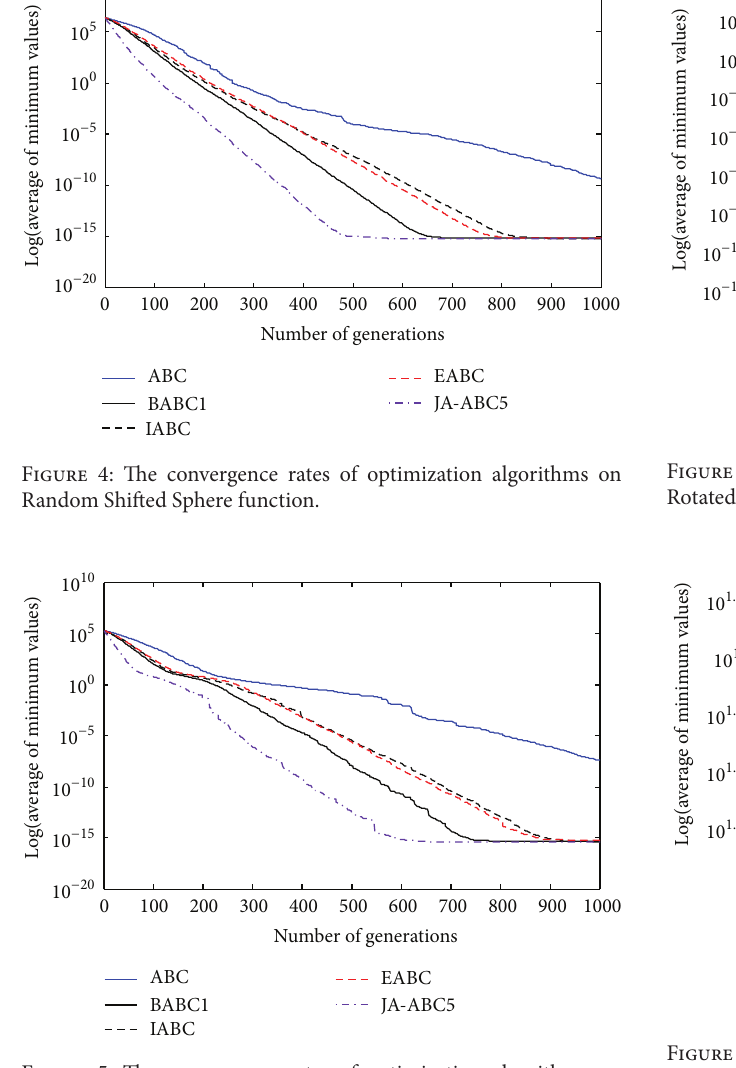
Figure 5: The convergence rates of optimization algorithms on Bohachevsky 2 function.